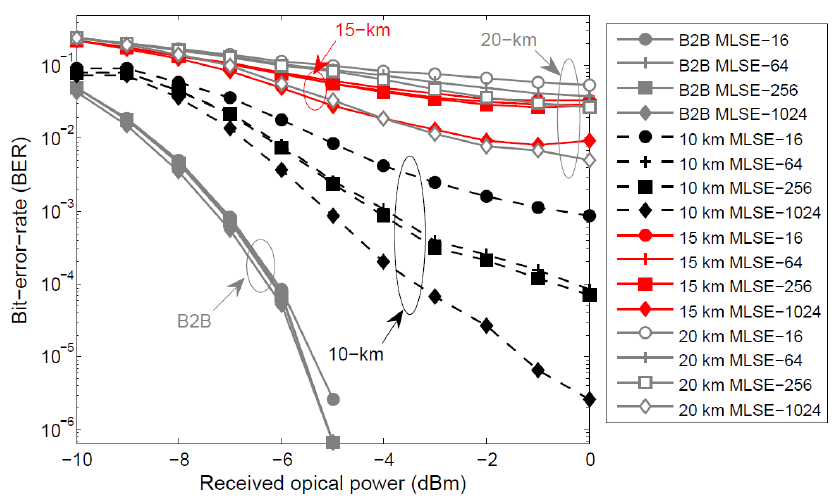
Figure 7. BER vs. received optical power when a 16-, 64-, 256-, and 1024-level MLSE.